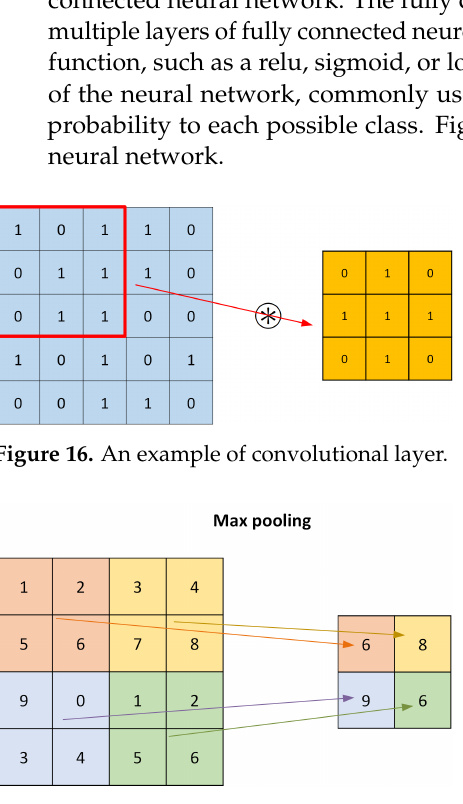
Figure 17. An example of max pooling.